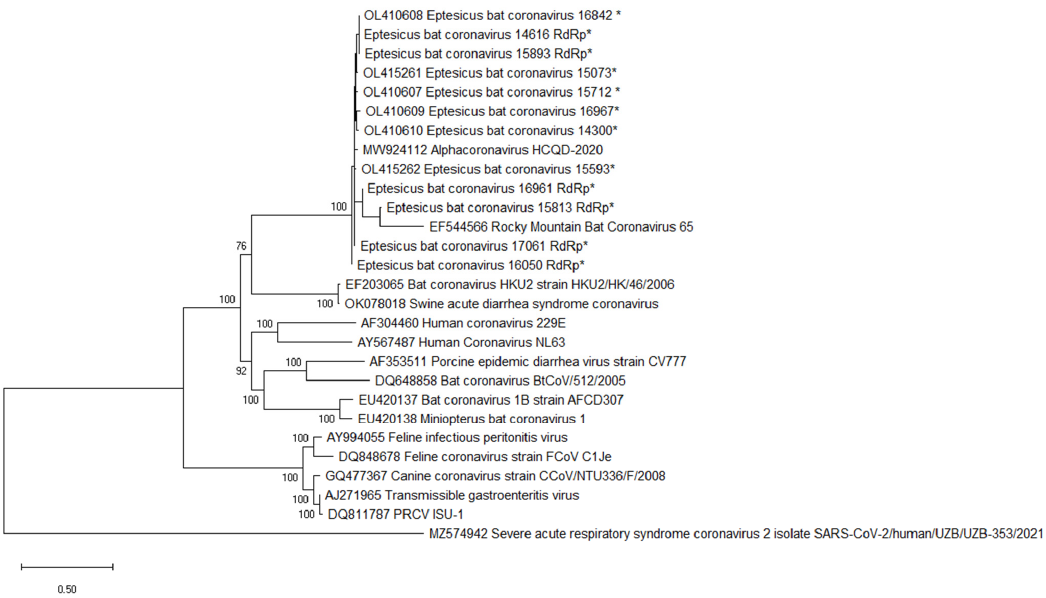
Figure 4. Phylogenetic analysis of ORF1ab nucleotide sequences was performed in MegaX using the maximum likelihood method along with a GTR + G substitution model [21,22]. The bootstrap values were calculated from 500 replicates, and values greater than 70 are shown. EbCoV sequences with the RdRp suffix are partial sequences derived from the nested PCR amplicon. Sequences determined here are indicated by *.